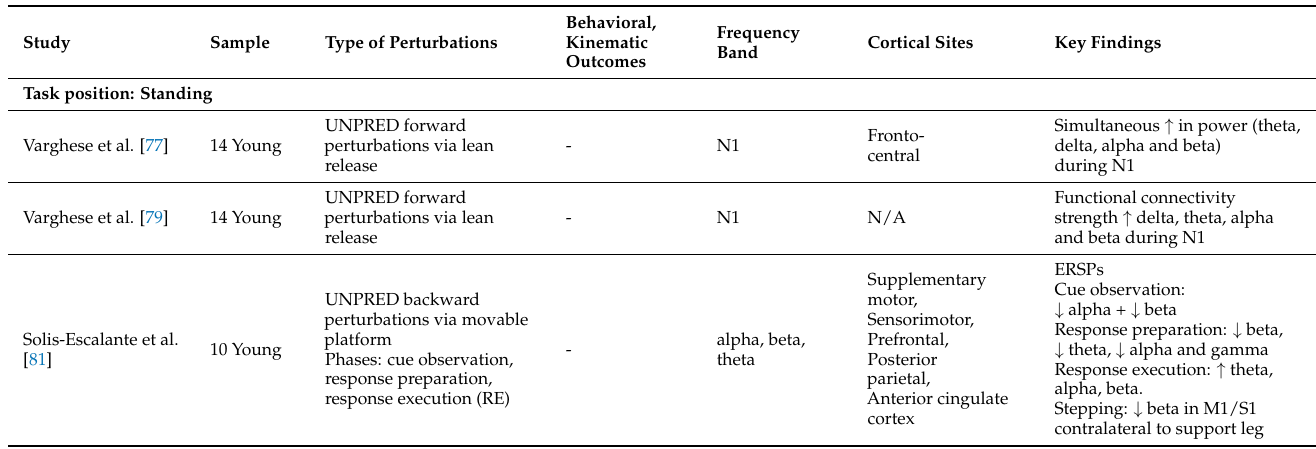
Table 3. Changes in frequency spectrums recorded via electroencephalography (EEG) in response to unpredictable (UNPRED) mechanical perturbations